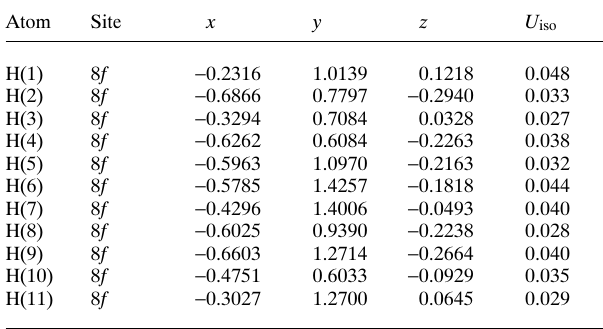
Table 2. Atomic coordinates and displacement parameters (in Å 2 )